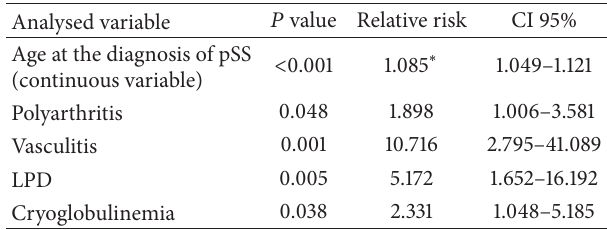
Table 6: Mortality risk in subgroups with significantly worse survival indicators, also taking into consideration the age recorded at the